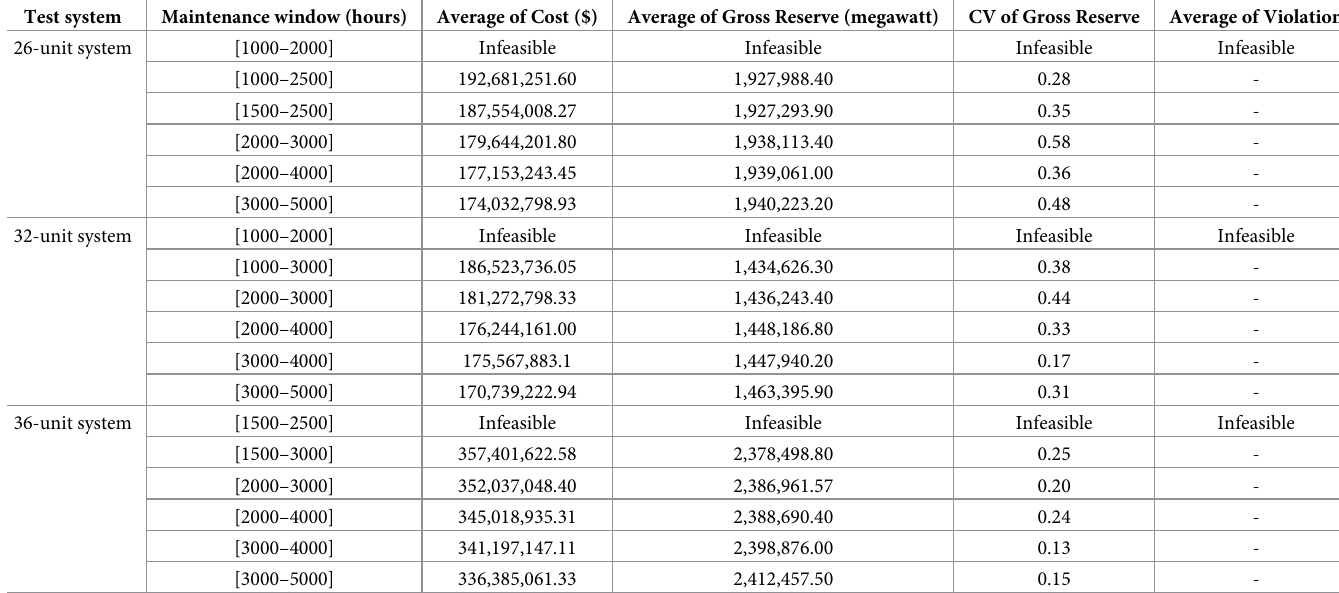
Table 7. Results of GMS model I